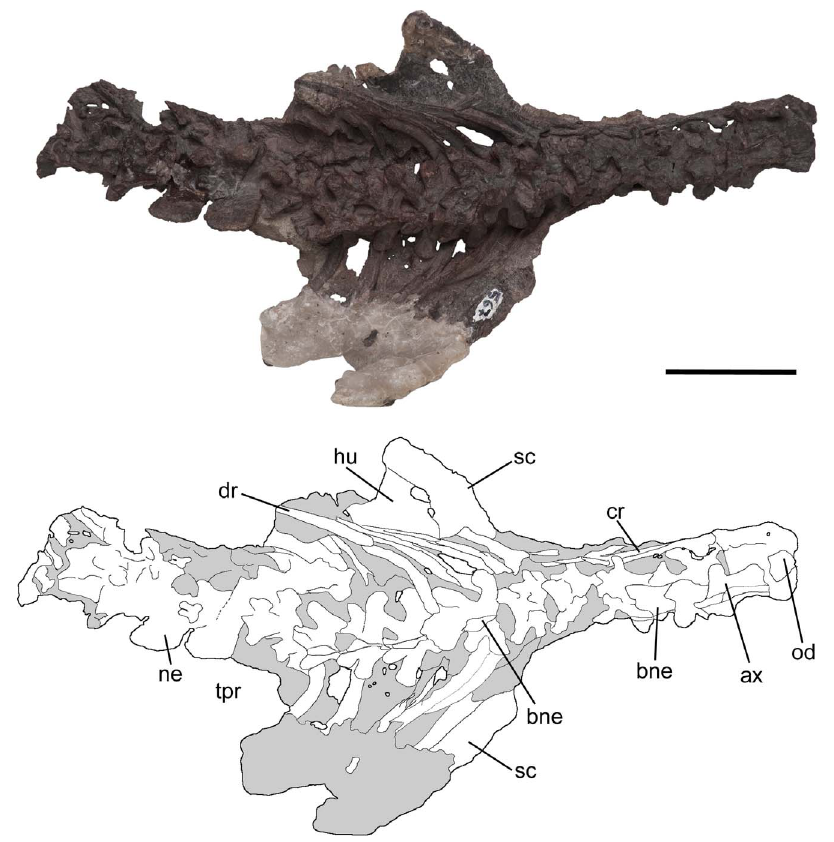
Figure 5. Cervical and dorsal vertebrae, and scapulacoracoids of Pseudochampsa ischigualastensis (PVSJ 567) in dorsal view. Abbreviations: ax, axis; bne, base of neural spine; cr, cervical rib; dr, dorsal rib; hu, humerus; ne¸neural spine; od, odontoid; sc, scapulacoracoid; tpr, transverse process. Scale bar equals 5